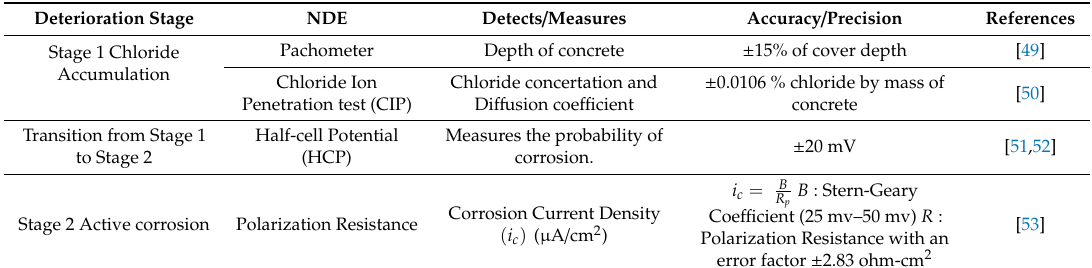
Table 1. Non-destructive inspection techniques available for RC bridge decks at di ff erent deterioration